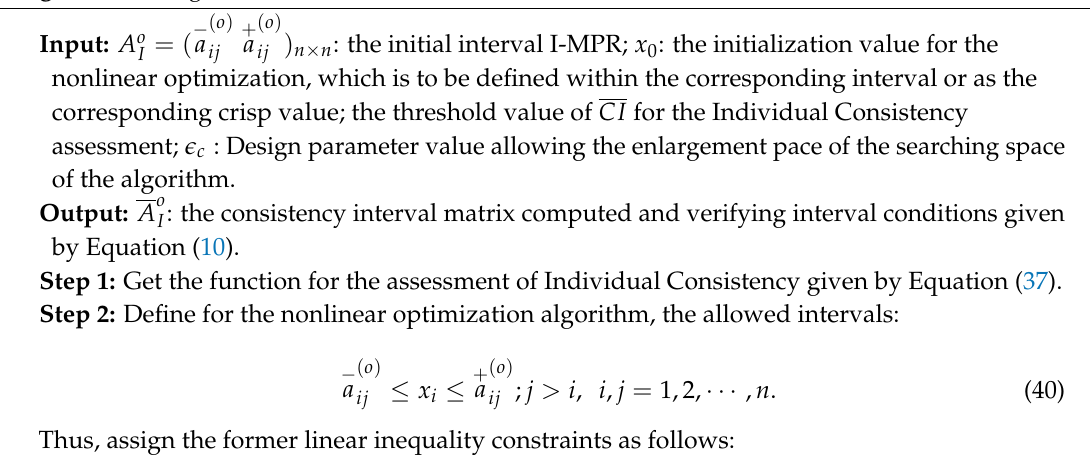
Algorithm 1: Algorithm